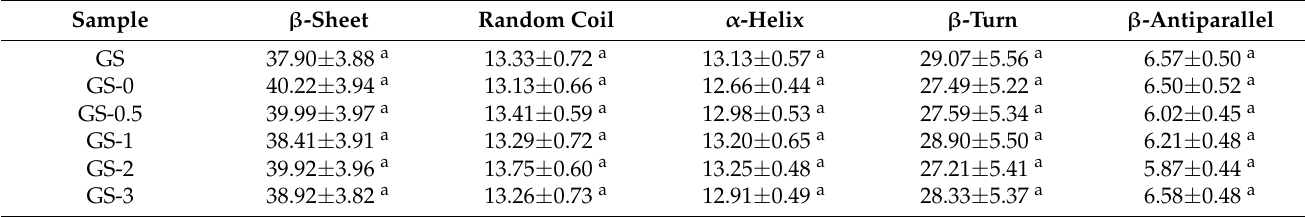
Table 9. Secondary structure percentage (%) analysis of Grass carp scale gelatin by analyzing the areas of 1600–1700 cm − 1 in FTIR